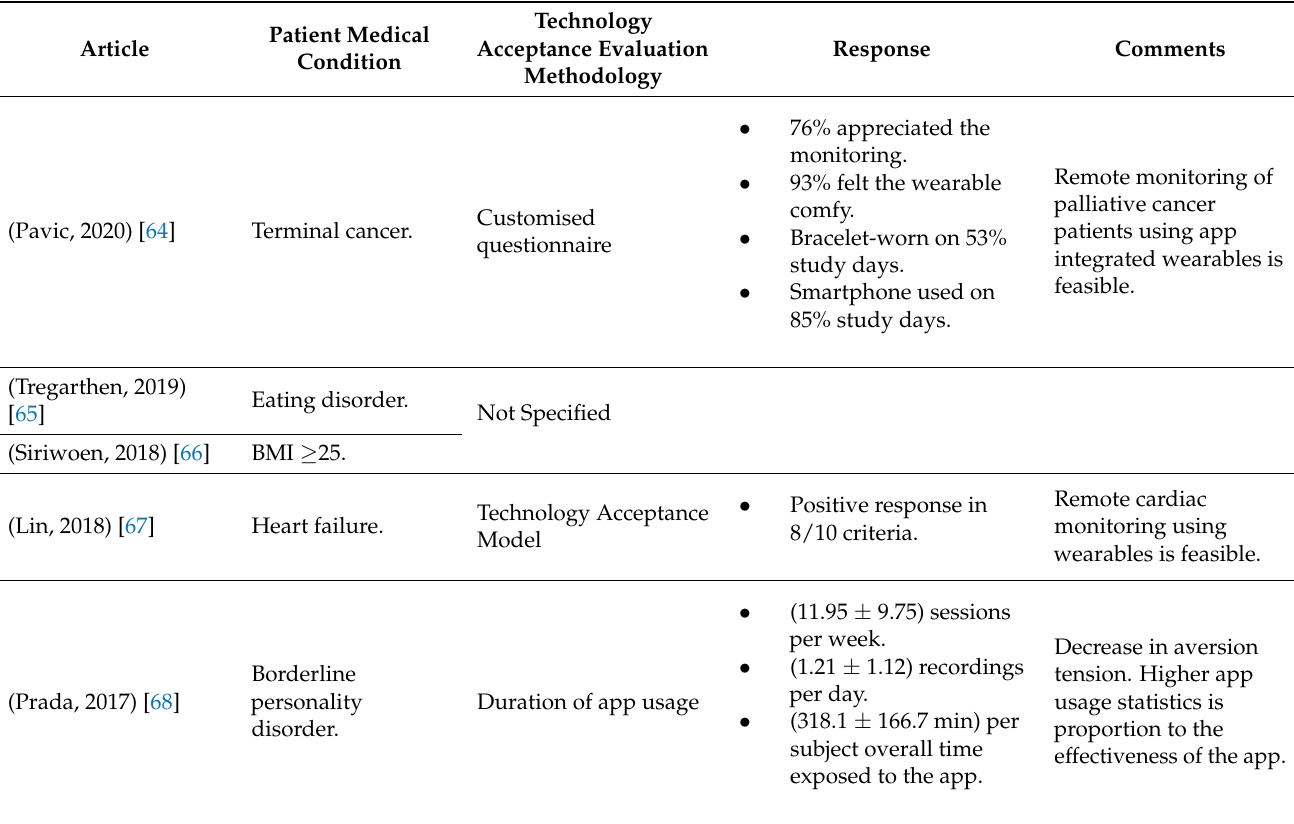
Table 4. Technology acceptance